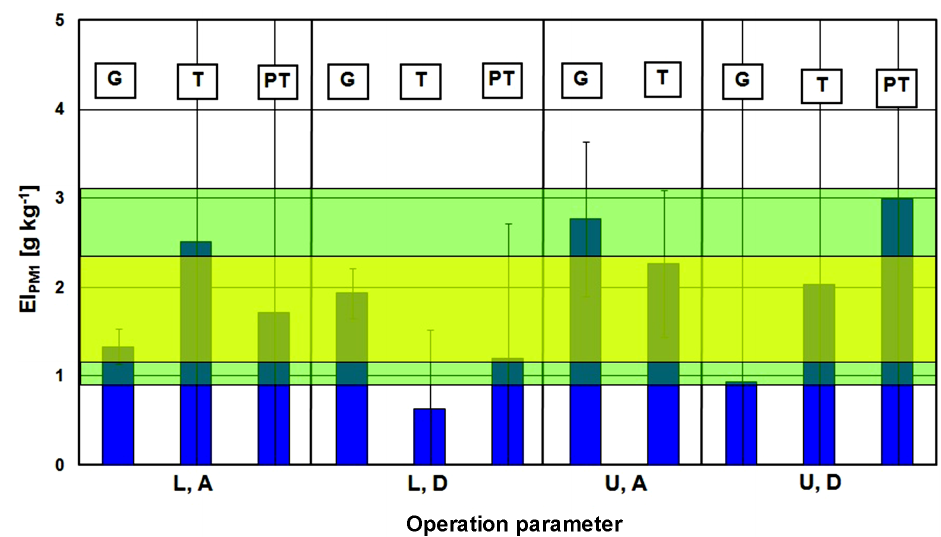
) ingkg − 1 burnt fuel for different motor ship types (G = goods, Figure 9. Weighted average lower limit emission index for PM 1 (EI PM 1 T = tanker and PT = push–tow) at different operation parameters (L = loaded, U = unloaded, A = upstream and D = downstream), in com- parison with German guidelines (BinSchAbgasV, 2005 (yellow) and RheinSchUO, 2011 (green)). Table 1. Emission indices NO x and PM 1 in gkg − 1 burnt fuel calculated from the measured values in comparison with different literature data from inland water